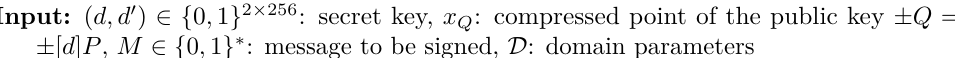
Algorithm 1 qDSA signature generation